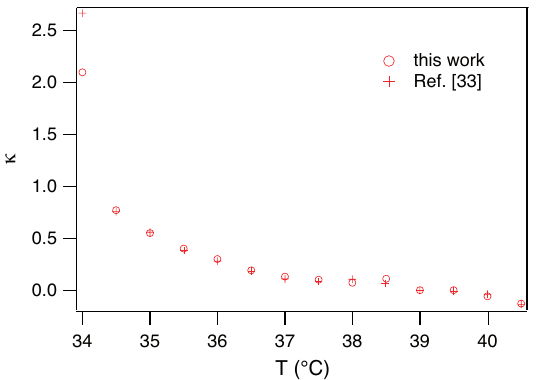
Figure 10. Values of κ obtained from the fit of the capacitance curves shown in Figure 7 by taken into account the electric field variation of ε (cid:107) . The agreement with the values given by Morris et al. is